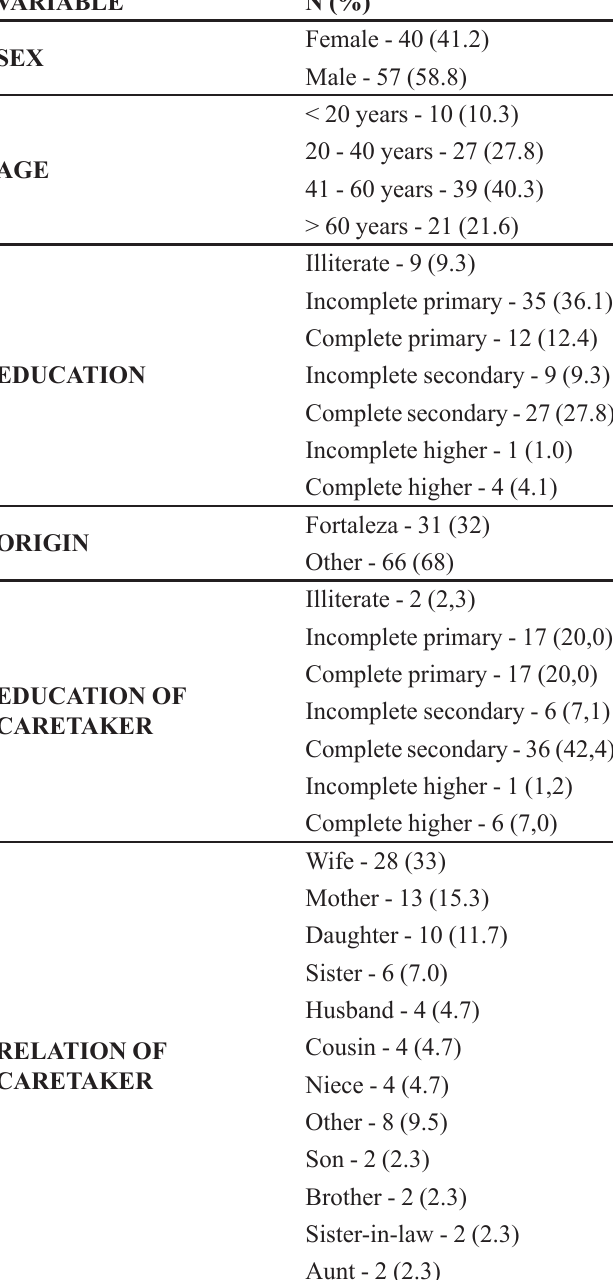
TABLE II - Medications utilized by the kidney and liver transplant patients seen by the Pharmaceutical Care service MAIN ANATOMICAL GROUPS